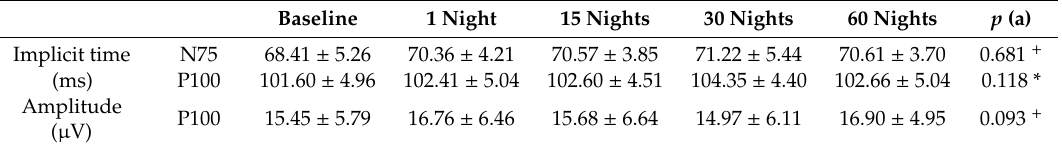
Table 3. Description (Mean ± SD) of the variation of the components of the VEP wave (implicit time of N75 and P100 (expressed in ms) and the amplitude of P100 (expressed in µ V)).